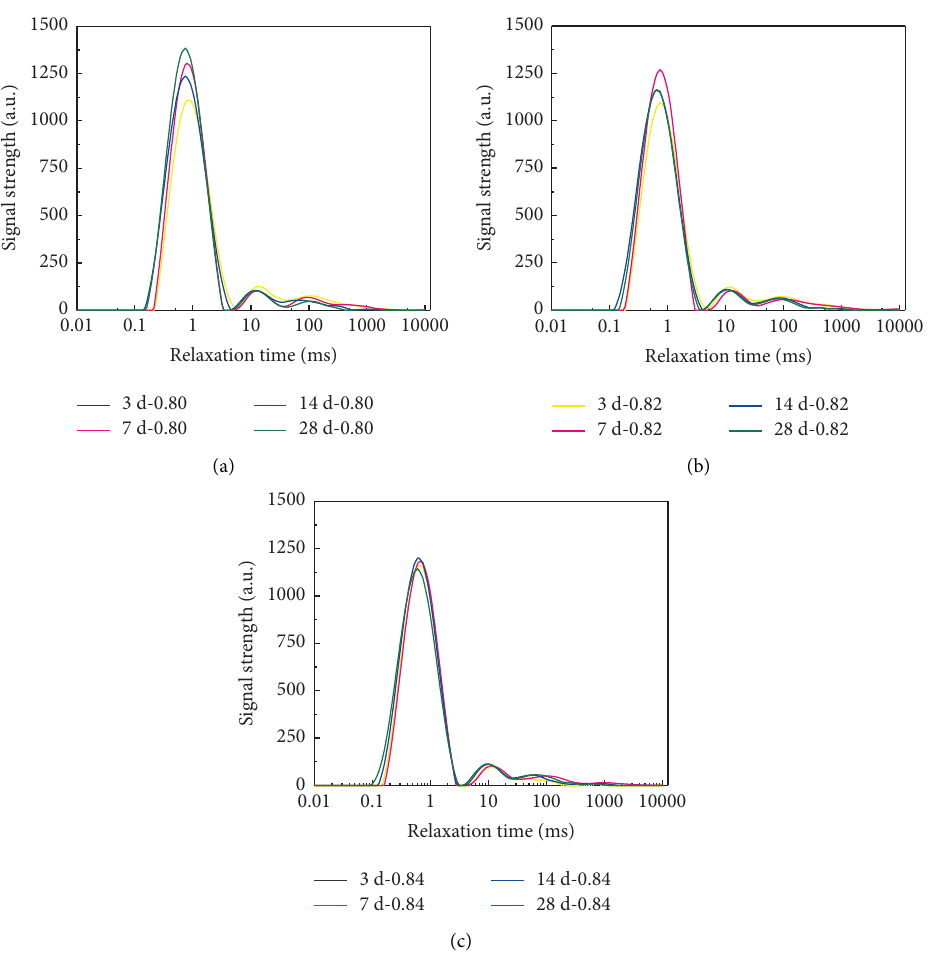
Figure 8: T 2 spectrum distribution curves of CGGCFB at diferent ages: (a) mass concentration 80%, (b) mass concentration 82%, and (c) mass concentration